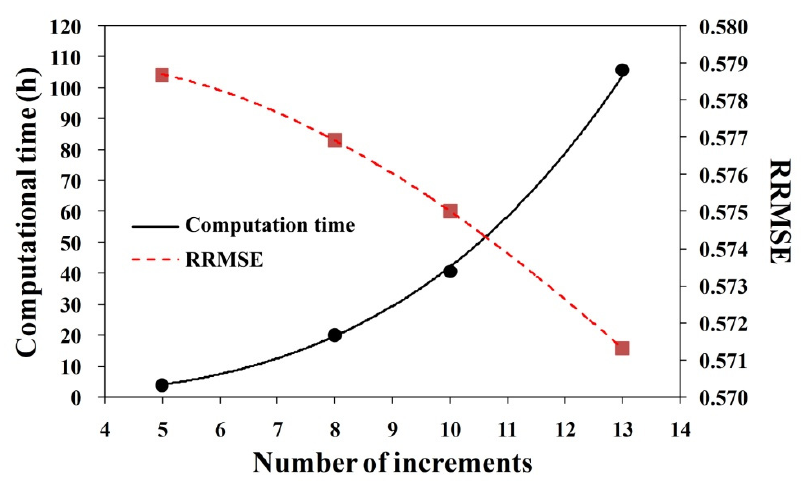
Figure 9. Effect of increment numbers on computational time and prediction